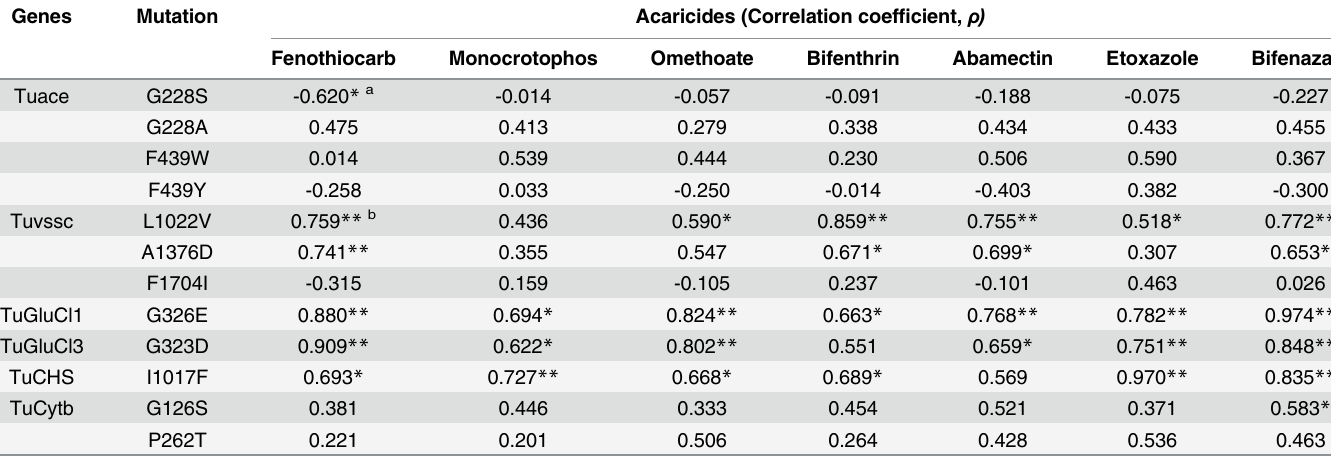
Table 5. Correlation coefficient between allele frequency of mutation and mortality determined by RCV from 12 strains. Genes